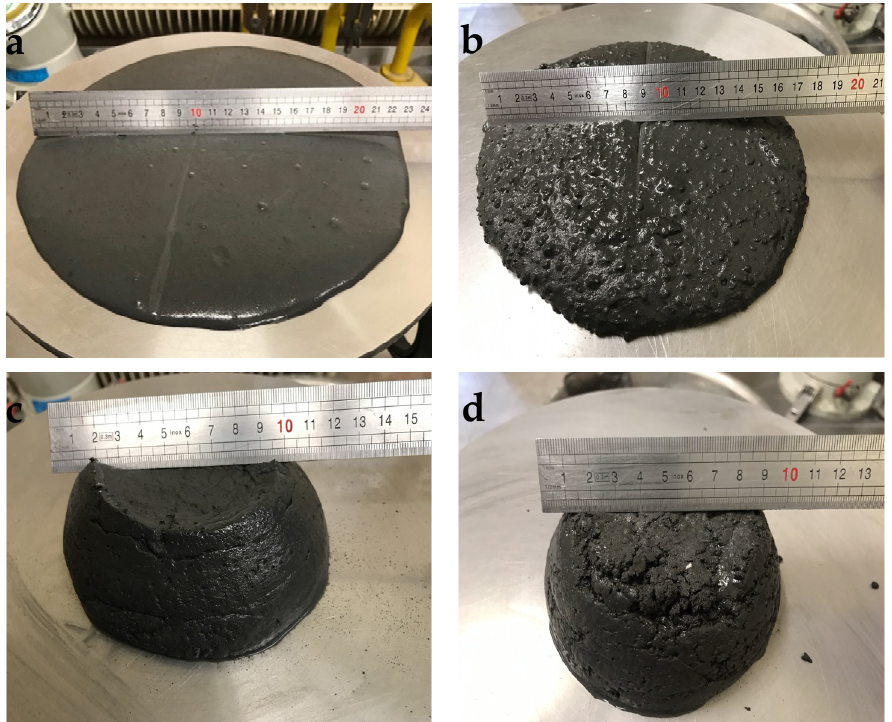
Figure 4. Flow diameter of RPC mix without lightweight aggregate ( a ), and containing 30% EP ( b ), 45% EP ( c ), and 60% EP ( d ).